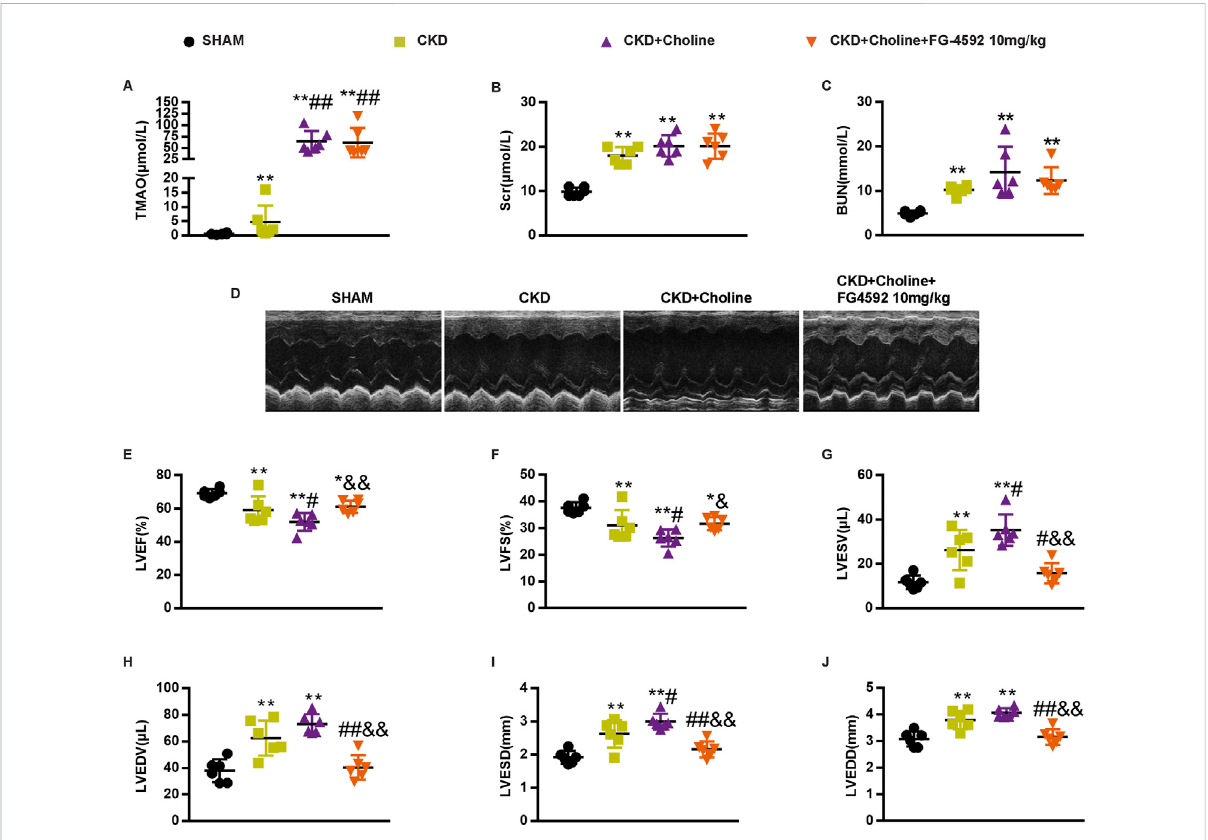
FIGURE 8 FG-4592 does not alter the level of TMAO, but improves cardiac dilation and dysfunction in 5/6 Nx mice on a high-choline diet. (A) The serum level of TMAO. (B) The serum level of Scr. (C) The serum level of BUN. (D) Representative M-mode echocardiograms for each group. (E –